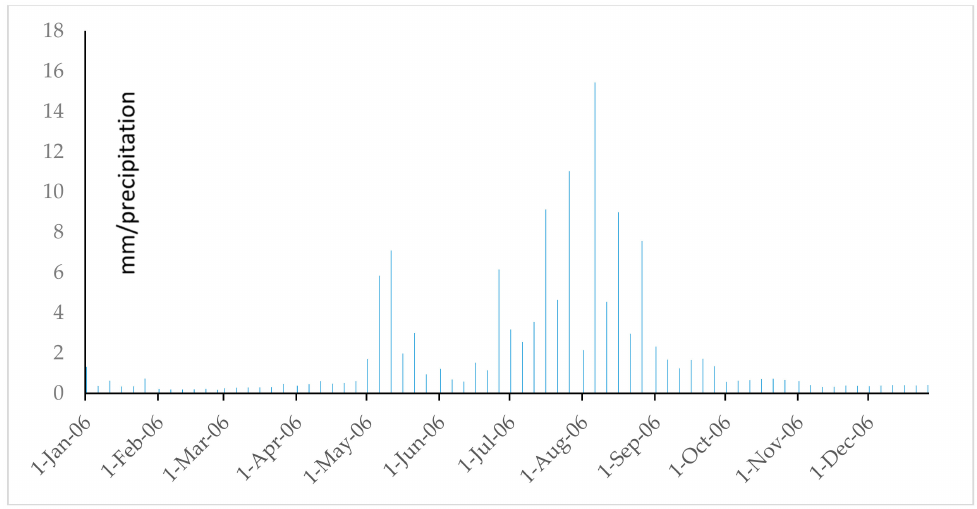
Figure A34. Precipitation of Denko County in 2006.